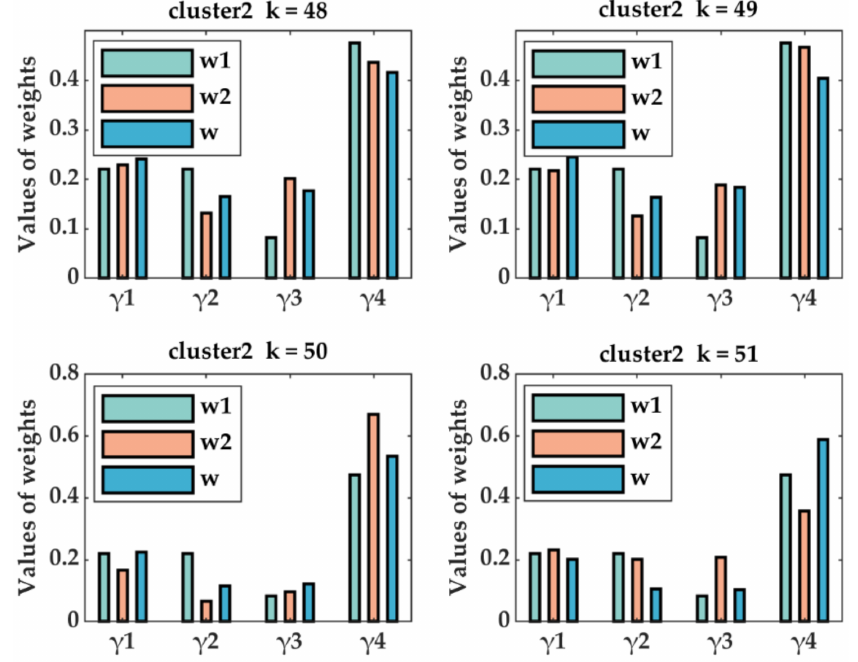
Figure 6. Weights of each index for DGs in cluster 2.